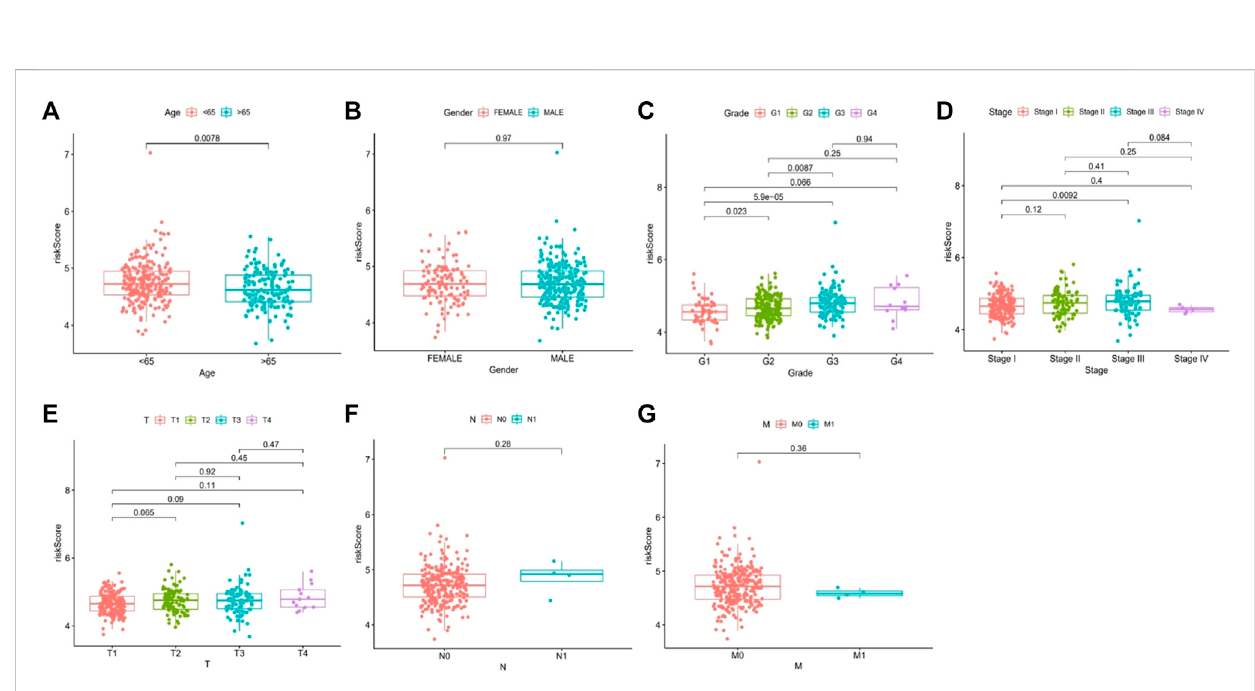
FIGURE 8 Correlation analysis of risk score and related clinical characteristics. [ (A) : age, (B) gender, (C) grade, (D) stage, (E) T stage, (F) N stage, (G) M